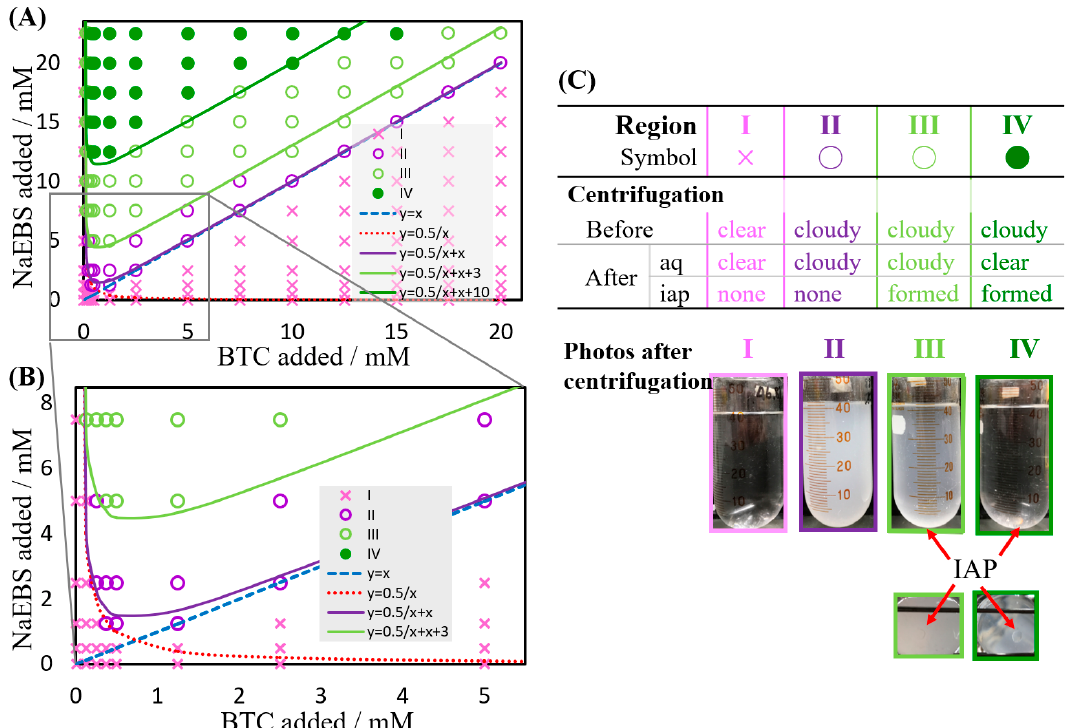
Figure 8. Effects of BTC and NaEBS concentrations on the formation of IAPs, and their corresponding photographs. ( A ) Effects of BTC and NaEBS concentrations on the formation of IAPs, ( B ) magnification of part of A, ( C ) legend and corresponding photographs.